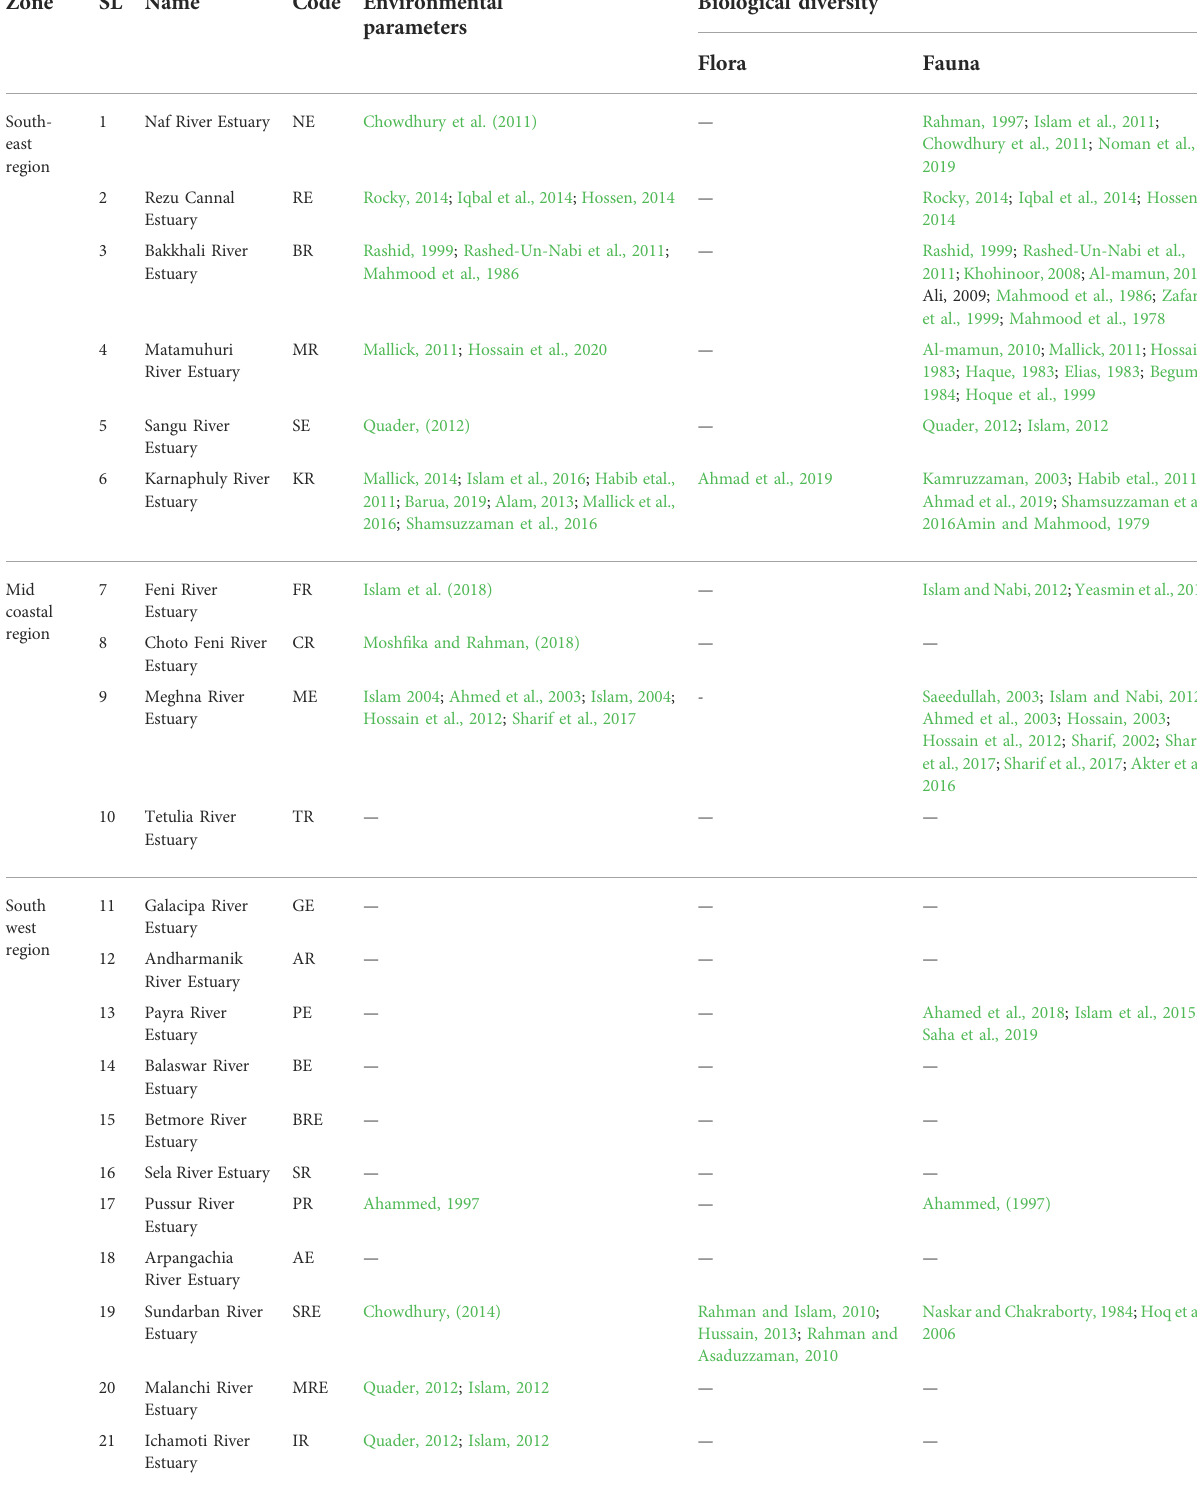
TABLE 1 Available research from various estuaries near Bay of